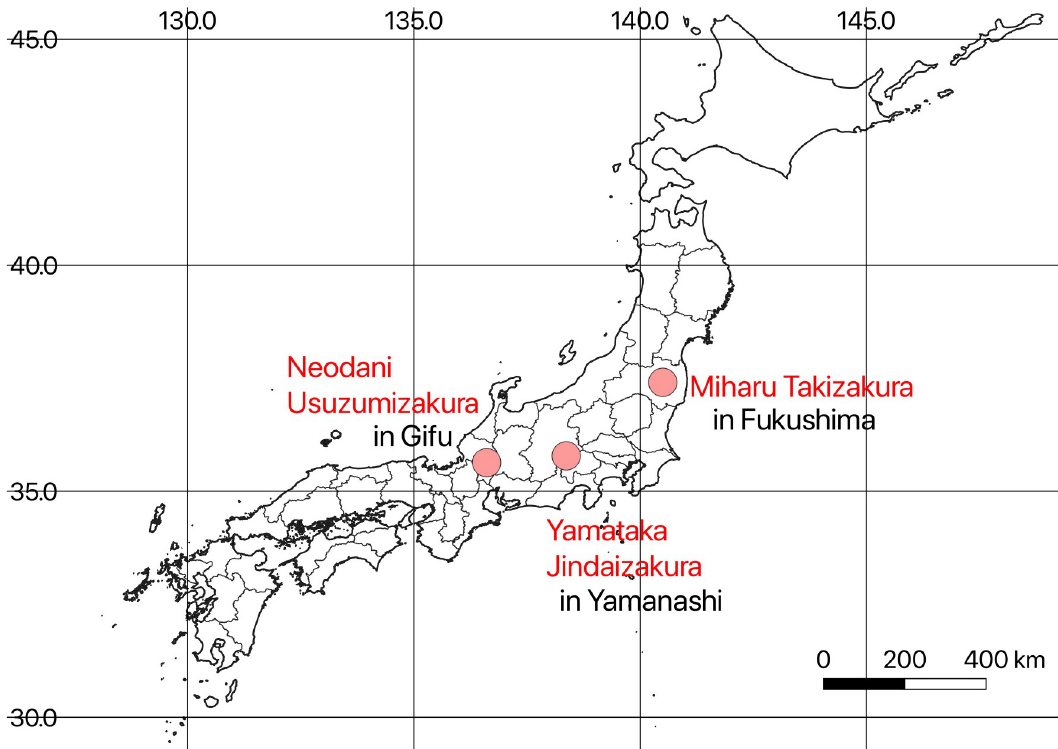
Fig 1. Locations of three famous cherry trees in Japan (data from Ministry of Land, Infrastructure, Transport and Tourism of Japan [27]). Latitude and longitude values were examined by using “Google Maps”.